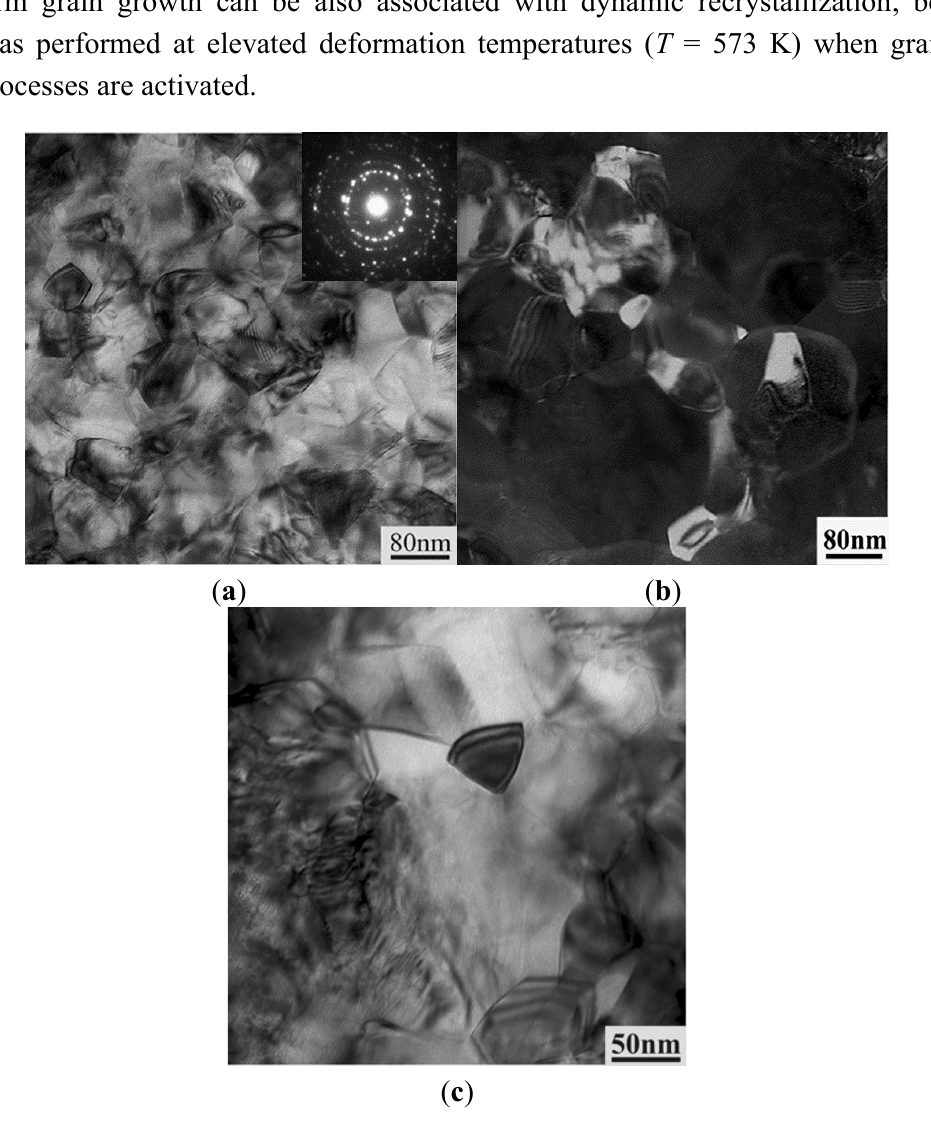
Figure 2. ( a , b ) Bright-field and dark-field images of ultrafine grains formed in peripheral part of the sample; ( c ) ultrafine